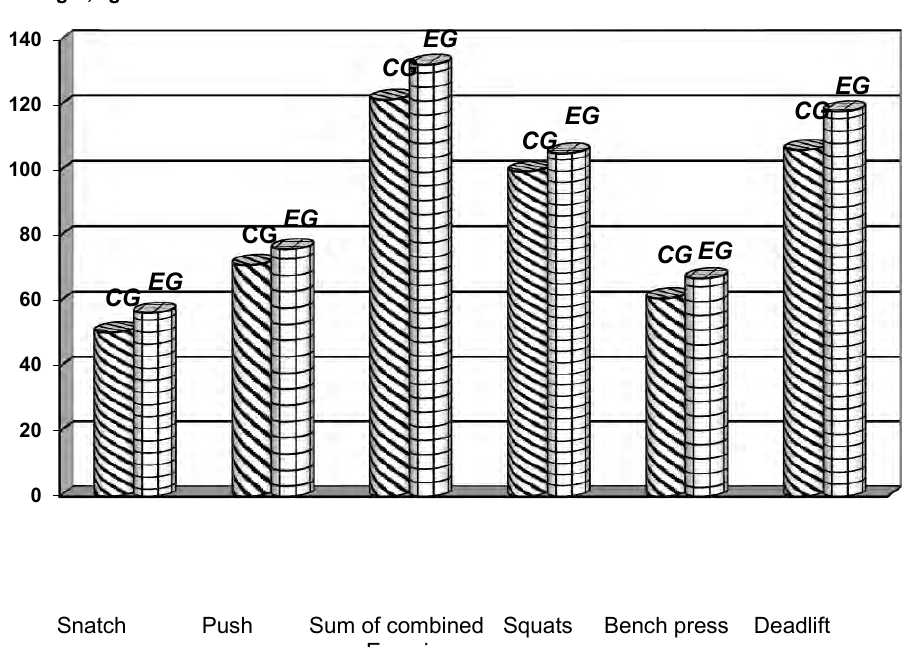
Fig. 2. Comparative analysis of special exercises’ fulfillment in control (CG) and experimental (EG) groups at the end of preparatory